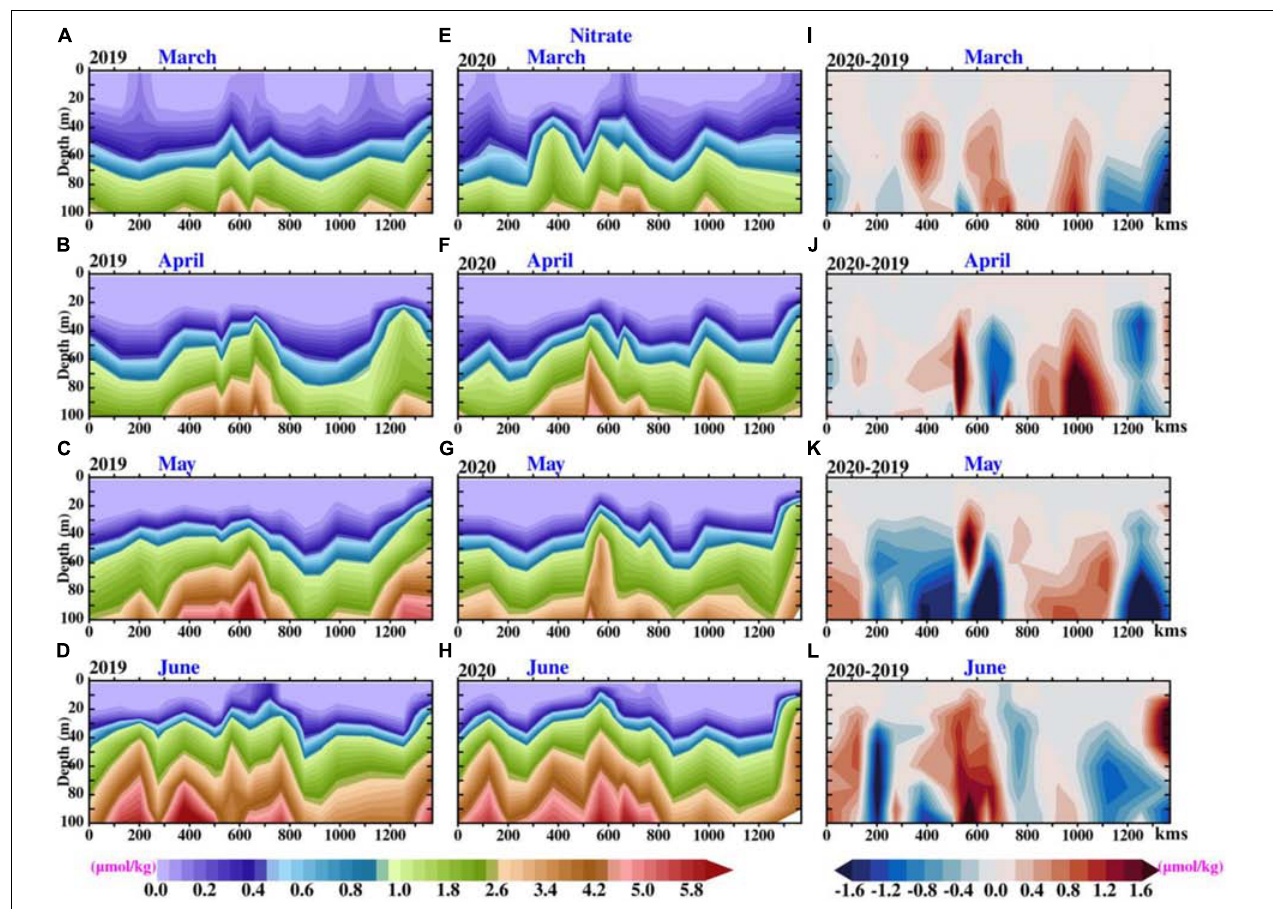
FIGURE 14 | Evolution of model-simulated nitrate profile along 1,000 m isobath off Oman coast (as shown in Figure 1 ): (A–D) during the pre-pandemic period (March–June, 2019), (E–H) pandemic period (March–June, 2020), and (I–L) nitrate concentration difference (pandemic – pre-pandemic